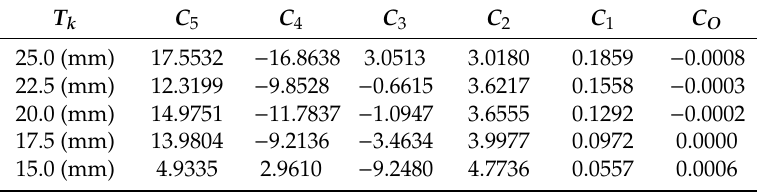
Table 3. Polynomial regression coe ffi cients for energy functions E s ( e c ) of five rubber fenders. T